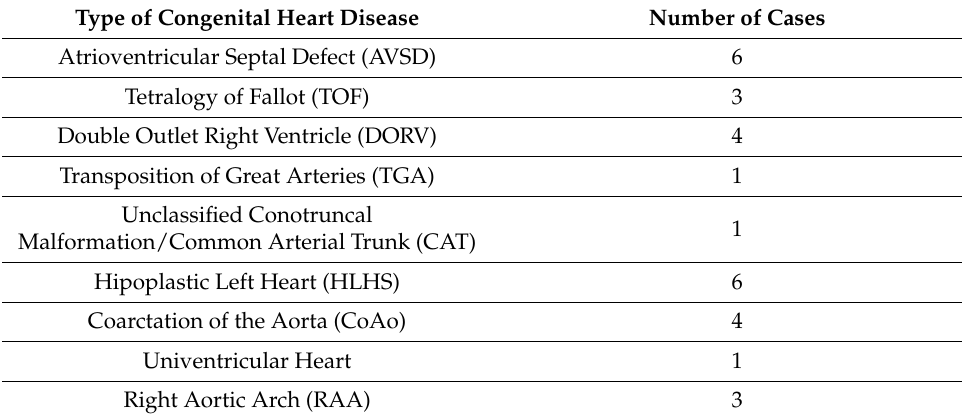
Table 1. Types of CHD included in the study. Type of Congenital Heart Disease Number of